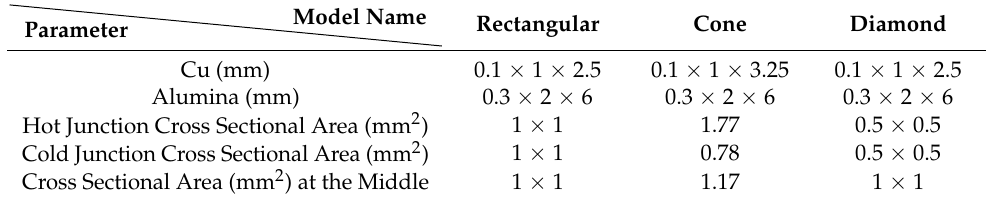
Table 2. TEG model